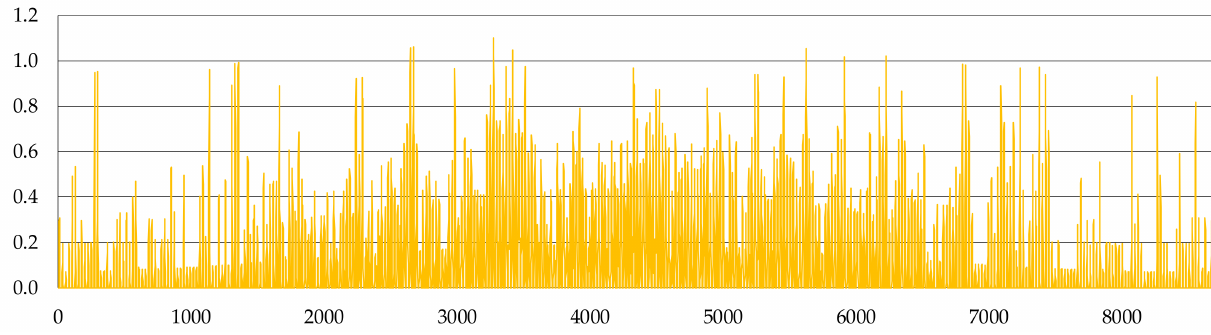
Figure 9. Solar irradiance (kW/m 2 ) during the typical meteorological year for the Katowice meteoro- logical